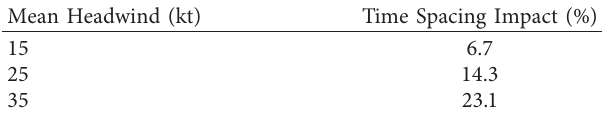
Table 9: Effect of headwind on land efficiency.